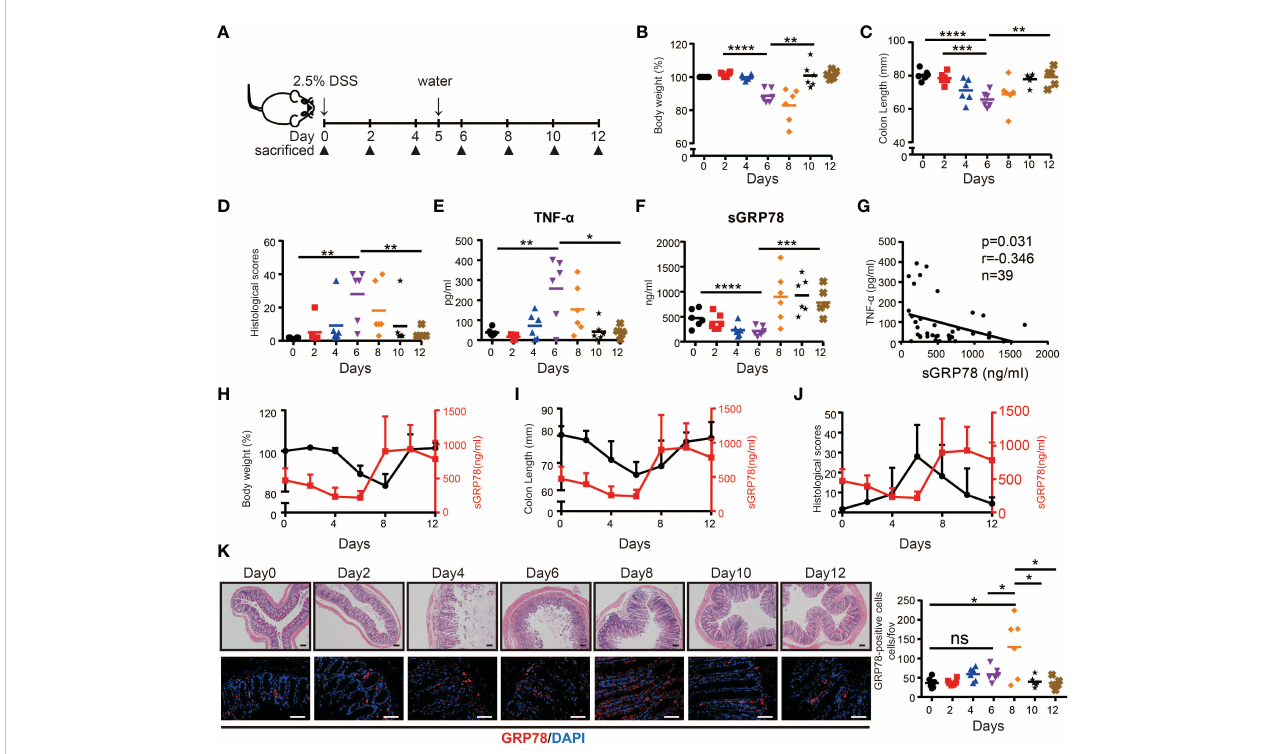
FIGURE 2 sGRP78 expression in experimental models of colitis. (A) Scheme of colitis induction. (B) Body weight was measured every two days and expressed as the percentage from day 0. At indicated time points, the colonic tissues were removed from sacri fi ced mice for following measurements: (C) Colon length. (D) Histological scores. Levels of TNF- a (E) and sGRP78 (F) in colonic punches supernatants. (G) Correlation analysis between sGRP78 and TNF- a (n=39). Pearson correlation coef fi cients (r) and p-values were calculated and shown. Relationship curve of sGRP78 with weight loss (H) , colon shortening (I) , and histological changes (J) in colitis. (K) Representative photomicrographs of colon sections (left) stained with HE (upper panel) or GRP78 (lower panel). (Day 0: black circle; Day2: red square; Day4: blue regular triangle; Day6: Purple inverted triangle; Day8: orange rhombus; Day10: black pentagram; Day12: brown error). Scale bar: 100 m m (upper panel) and 50 m m (lower panel). Numbers of GRP78-positive cells were calculated and shown in the right. Data represent mean ± SEM (n=5 – 6). ns, not signi fi cant. * p < 0.05, ** p < 0.01, *** p < 0.001, **** p <